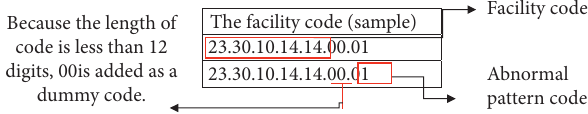
Figure 5: The sample of the proposed facility